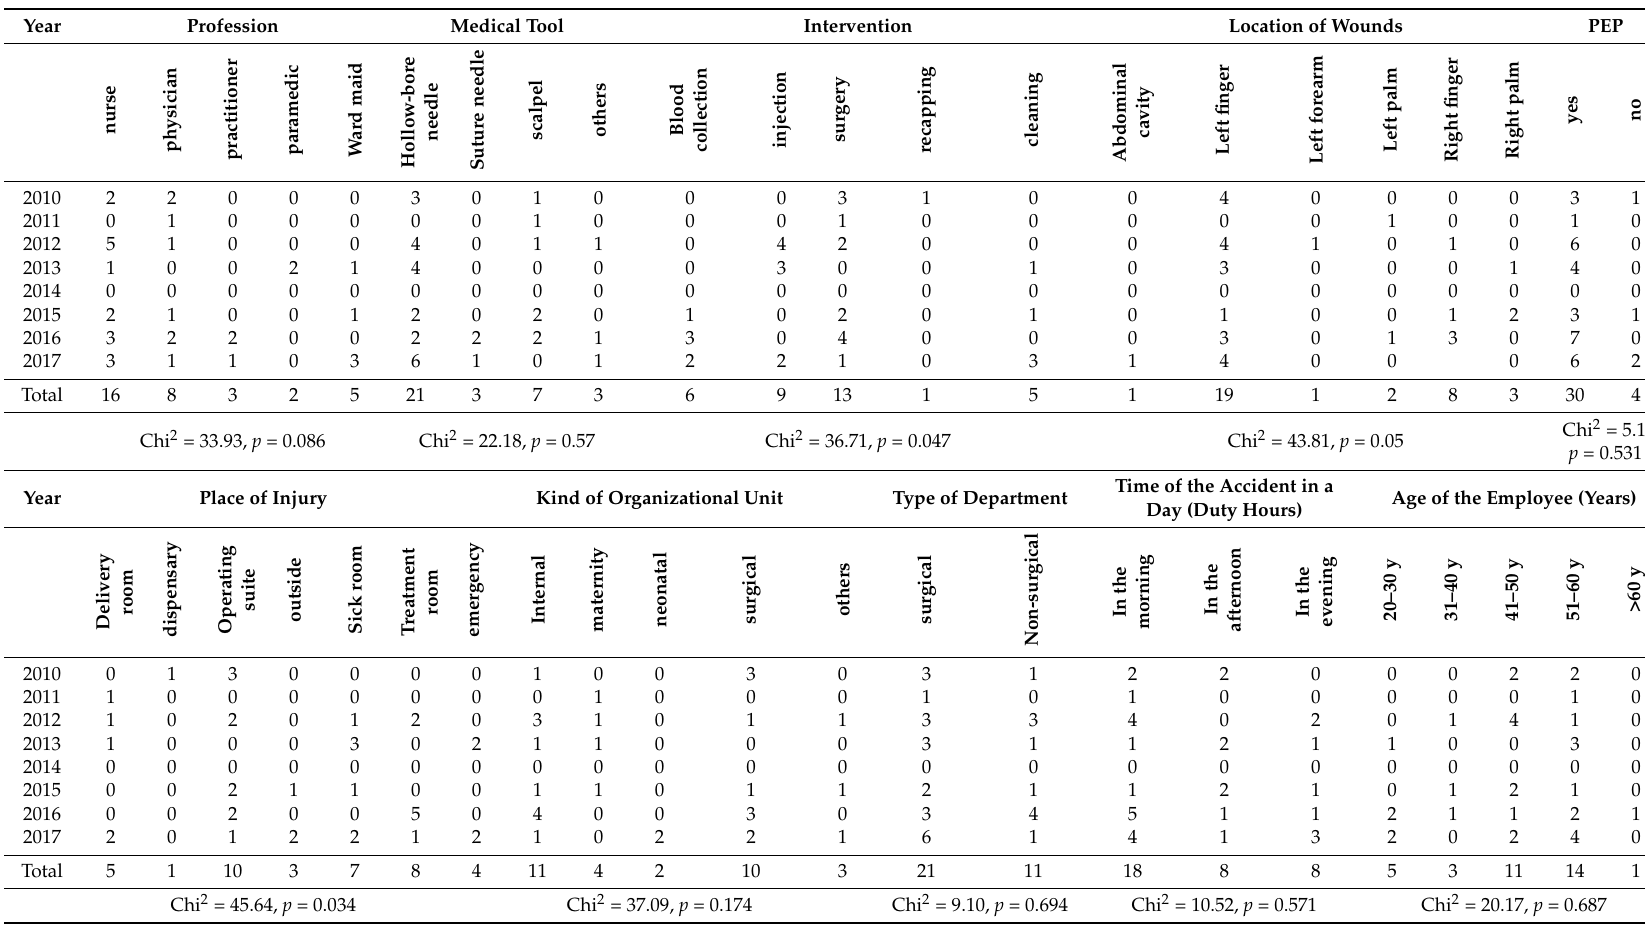
Table 2. Injuries recorded by year depending on the variables studied ( n =